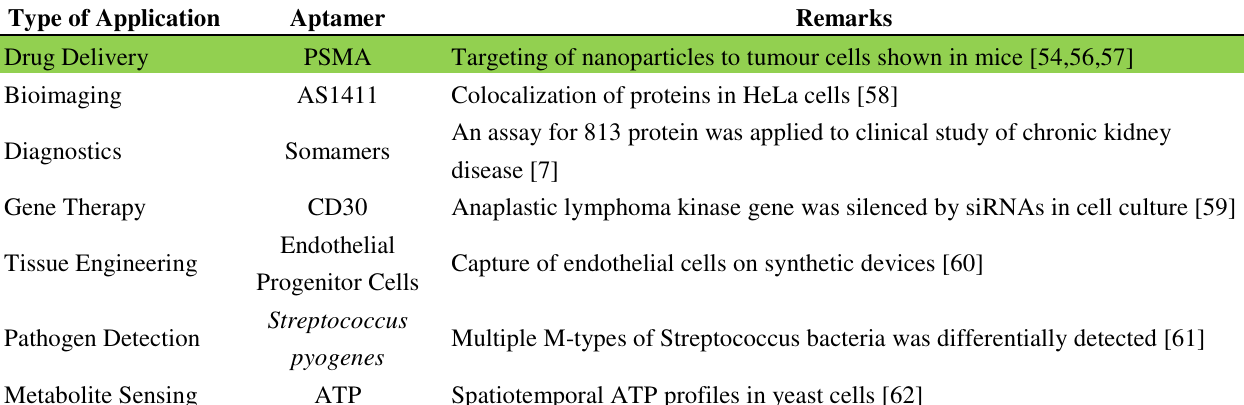
Table 2. Examples of medical applications with